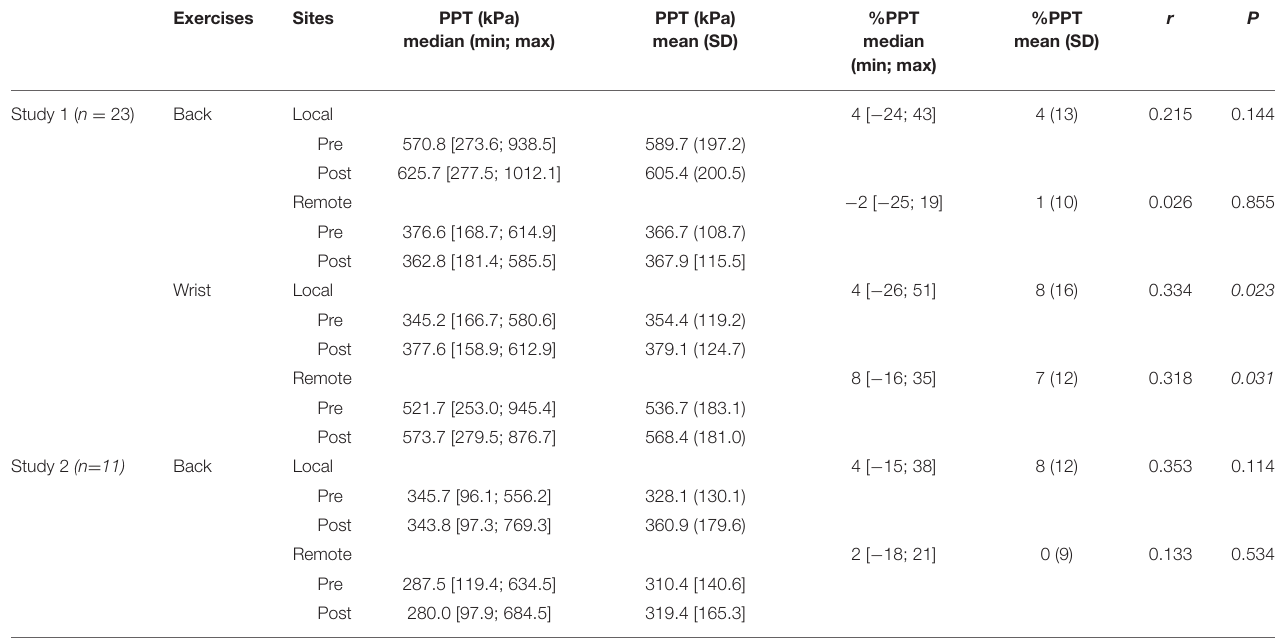
TABLE 2 | Exercise effects on pressure pain thresholds at local and remote